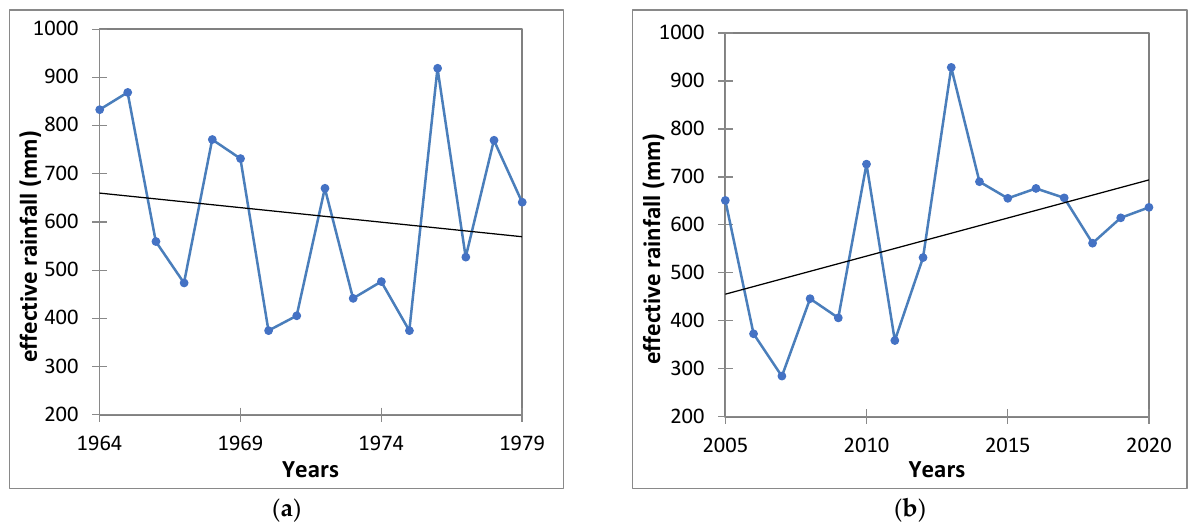
Table 5. Mann–Kendall and Sen’s slope test results for effective precipitation trend. Figure 10. Streamflow and trend line in black colour: ( a ) 1964–1979; ( b ) 2005–2020.